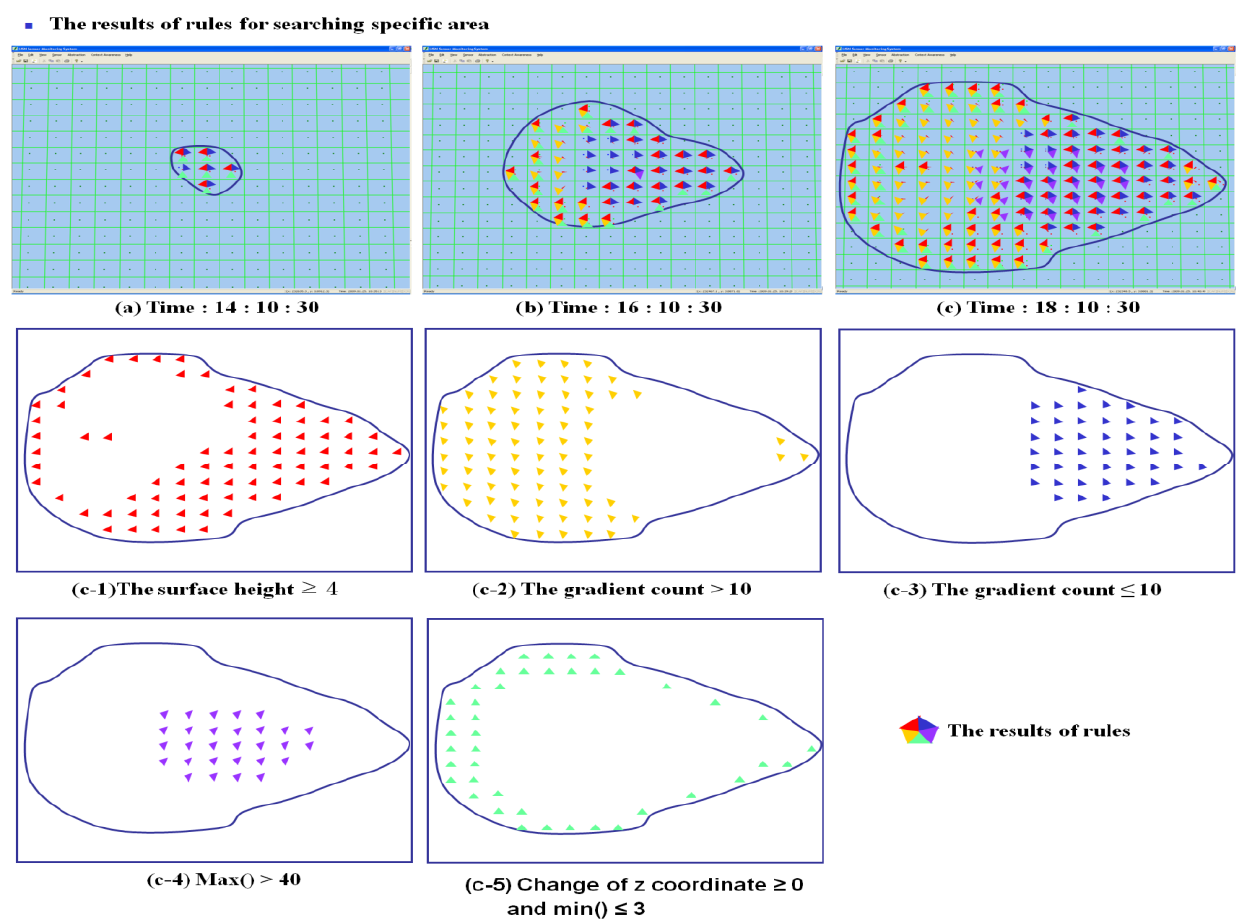
Figure 11. The results of user defined rules for checking the characters of the detected